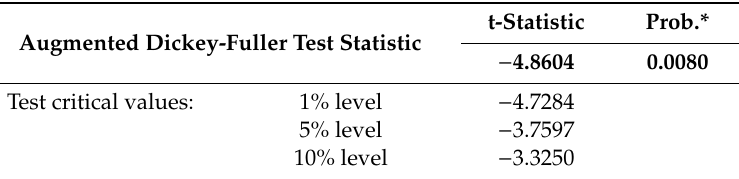
Table 5. Square root test results of first-order difference.